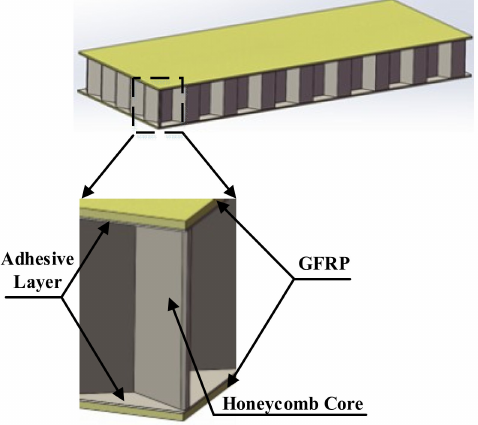
Figure 1. The diagram of honeycomb sandwich composite.